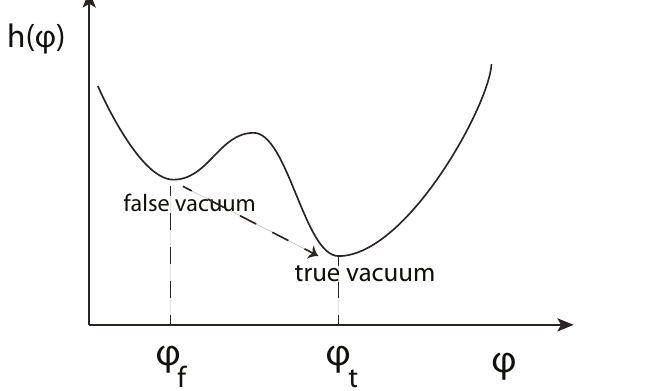
Figure 2 . The potential of the scalar field with two local minima. One is the false vacuum ( ϕ f ) and the other one is the true vacuum ( ϕ t